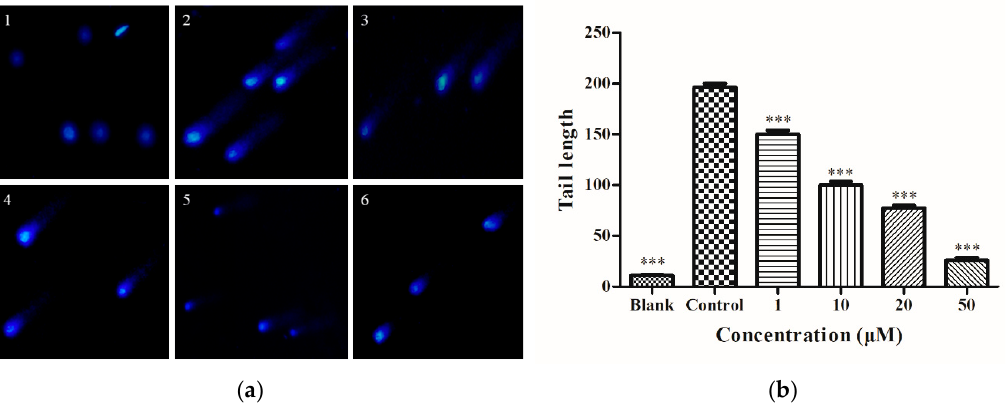
Figure 4. ( a ) Determination of intracellular DNA damage. (1) HepG2 cells without treatment (the blank group); (2) cells exposed to 0.5 M ethanol (the control group); (3)–(6) cells treated with DIF (1, 10, 20, and 50 μ M). ( b ) The tail length was analyzed. Data are shown as mean ± SD (n = 3). *** Compared with the control group, p < 0.001.